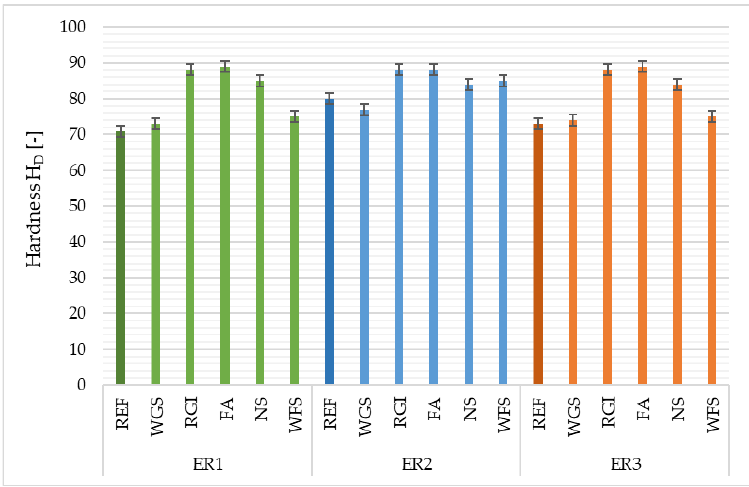
Figure 11. Surface hardness of epoxy composites depending on the type of filler and epoxy binder